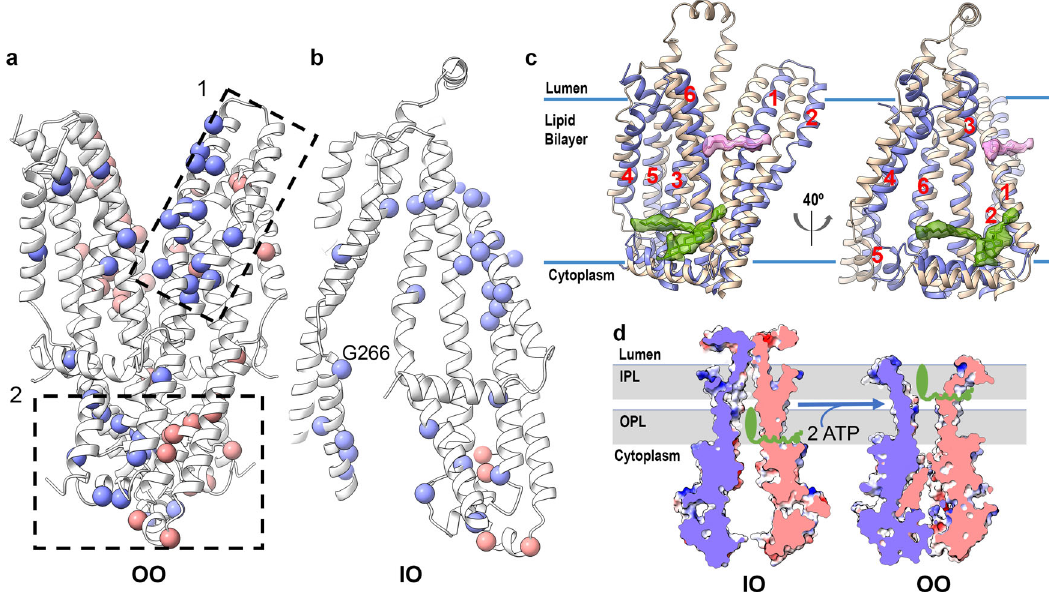
Fig. 4 Analysis of TMD mutations in ABCD1 and proposed substrate interactions. a ABCD1 TMD with C ɑ atoms of the most frequently mutated residues shown as spheres colored slate and pink for the two ABCD1 monomers and divided into two main clusters (dashed boxes 1 & 2). b Select ABCD1 disease- causing mutations mapped onto ABCD1 IO structure. c EM density (0.04 contour) of ABCD1 showing modeled lipid-like entities (green) observed near gap in the OO structure (blue), overlaid onto the IO structure (gold). Unmodeled lipid-like density is shown pink. d Hypothetical mechanism of ATP-dependent fatty-acyl-CoA (green) translocation across the peroxisomal membrane (gray) mediated by